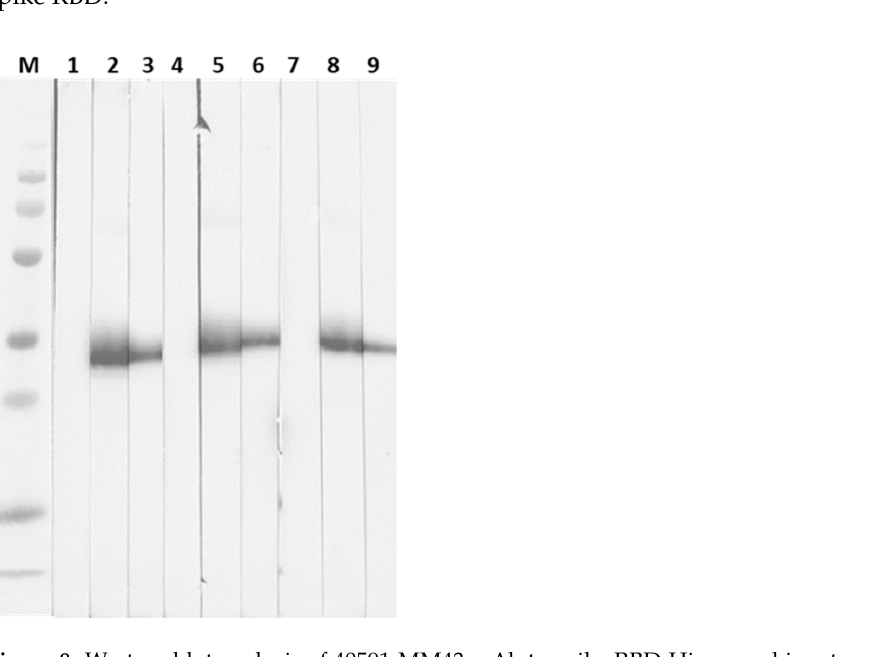
Figure 7. The RBD close and open states in the SARS-CoV-2-S protein (PDB ID: 7DDD and 7DDN). The chains A (yellow), B (cyan), C (white), and W436 residue (red) are displayed in the surface mode of UCSF Chimera.